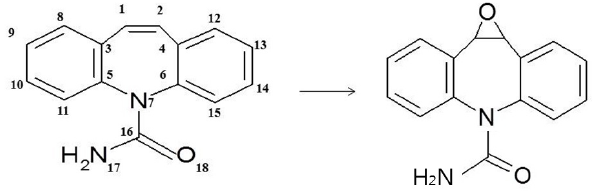
Figure 3. Structure of